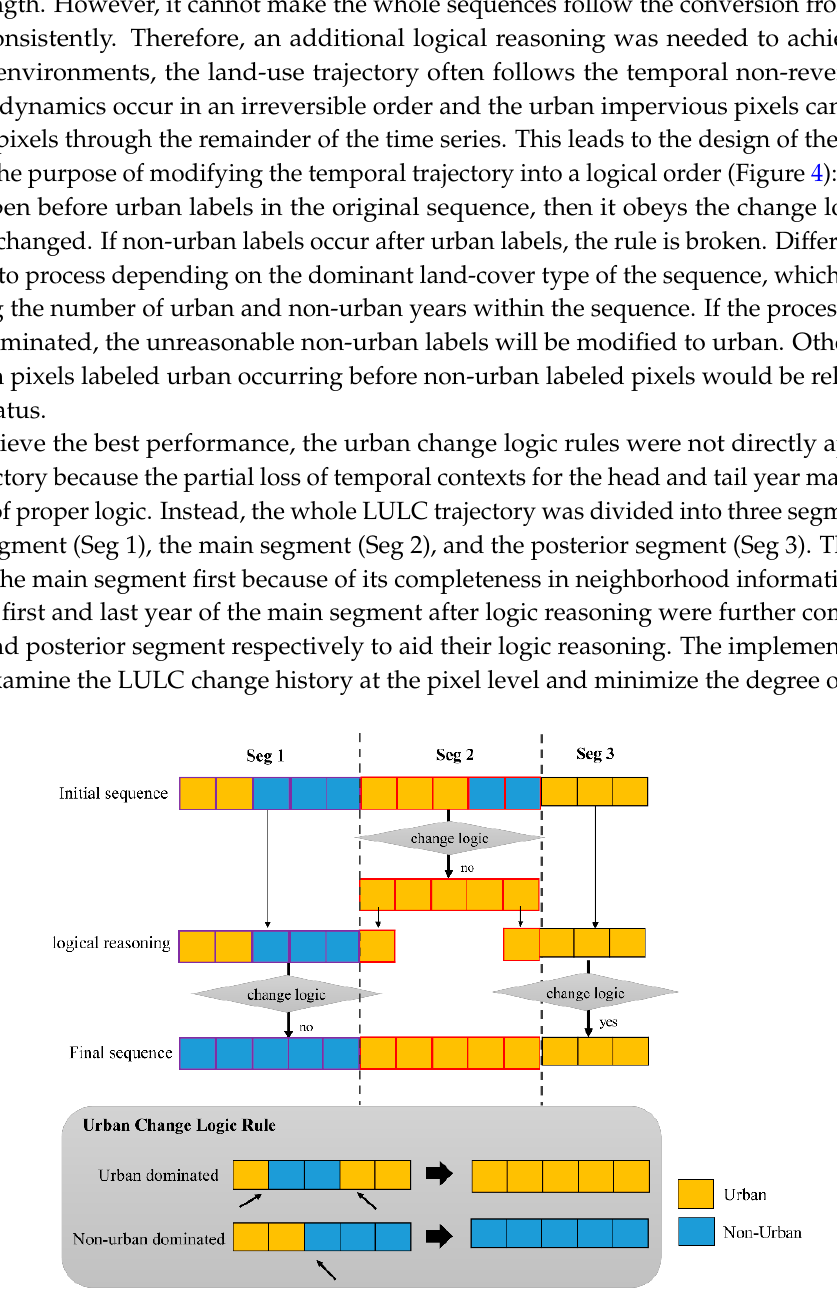
Figure 4. Illustration of urban change logic rule. The sequential process begins with an initially classified land-use trajectory and is then followed by the logical reasoning. Two examples of logic rules are given in the grey